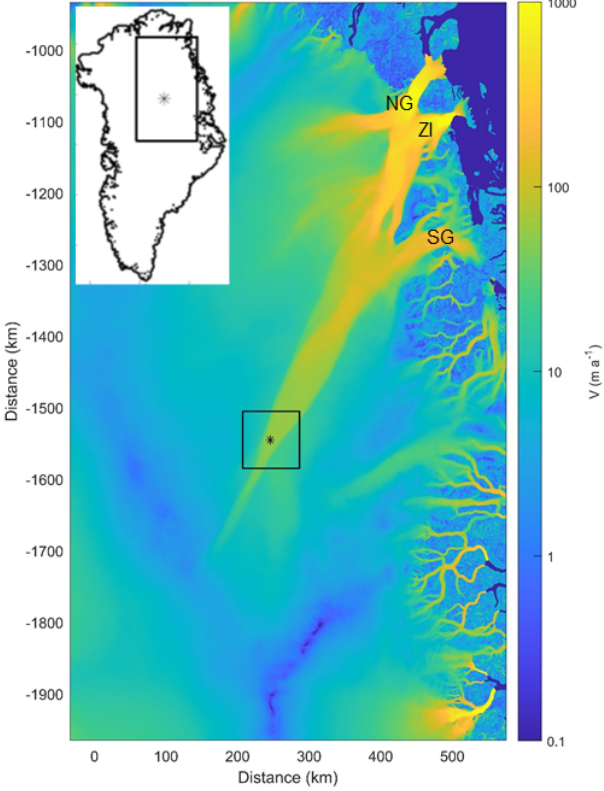
Figure 1. Map of the surface velocity in NE Greenland in meters per year from MEaSUREs Multi-year Greenland Ice Sheet Velocity v1 product, 1995–2015 (Joughin et al., 2016, 2018a), showing the NEGIS ice stream and its three main outlets: Nioghalvfjerdsfjorden Glacier (NG), Zachariae Isstrøm (ZI), and Storstrømmen Glacier (SG). The black box shows the outline of the map in Fig. 2, and the black star indicates the EastGRIP site (75 ◦ 38 (cid:48) N, 35 ◦ 60 (cid:48) W). The inset map shows the location in